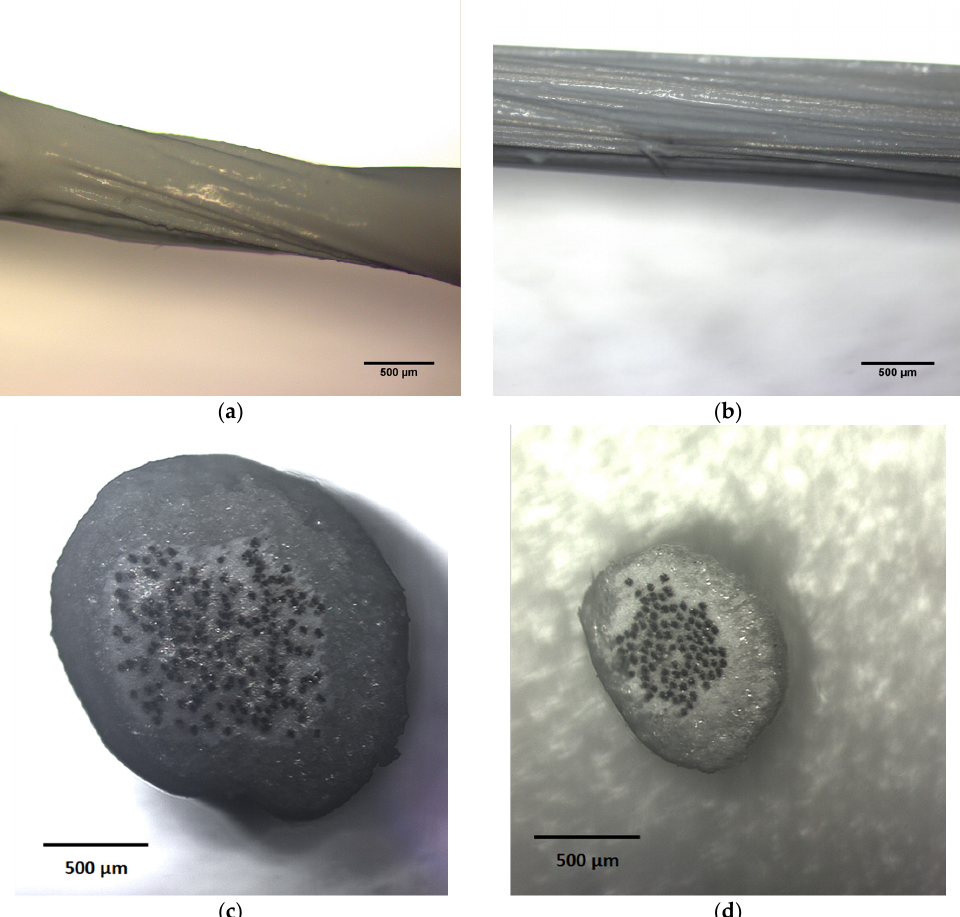
Figure 5. Optical microscope images (5× magnification) of the dielectric isolation layer coating of fibers produced via ( a ) dip-coating and ( b ) slot-die coating. Optical microscope images (5× magnification) of cross sections taken from the center of the ( c ) dip-coated and ( d ) slot-die coated fibers after deposition of the complete EL fiber structure.